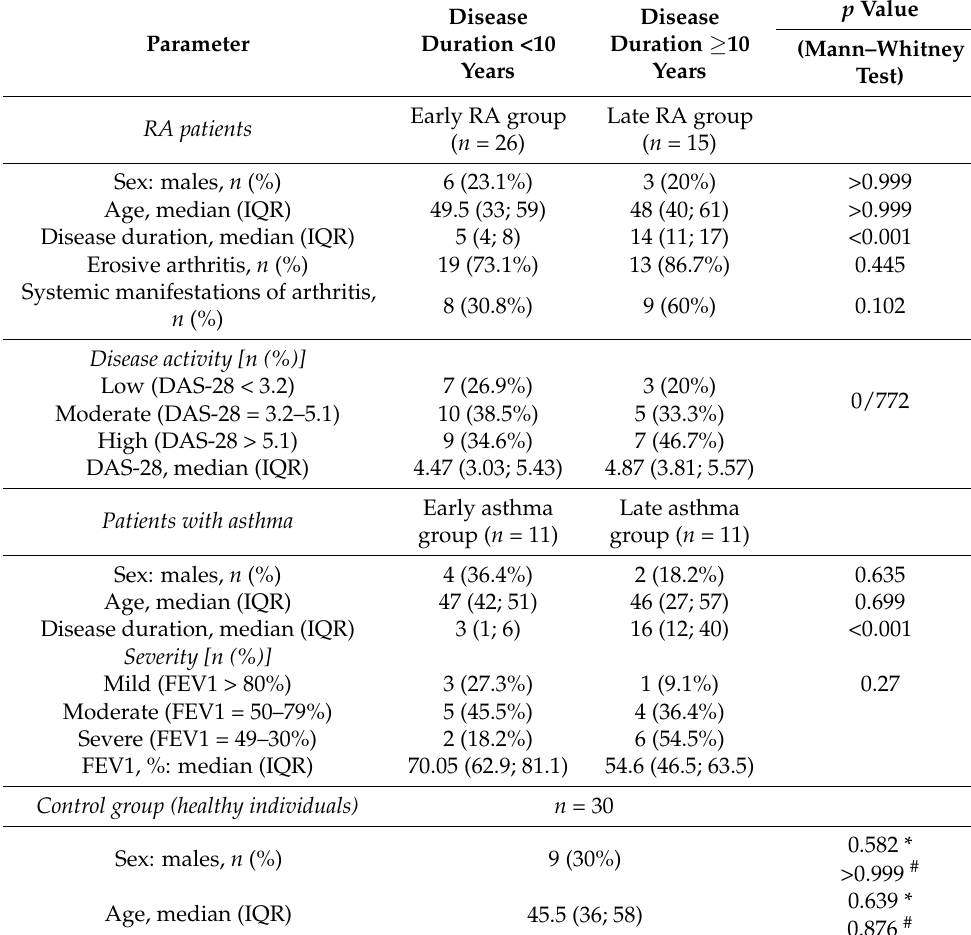
Table 1. Baseline characteristics of groups of human